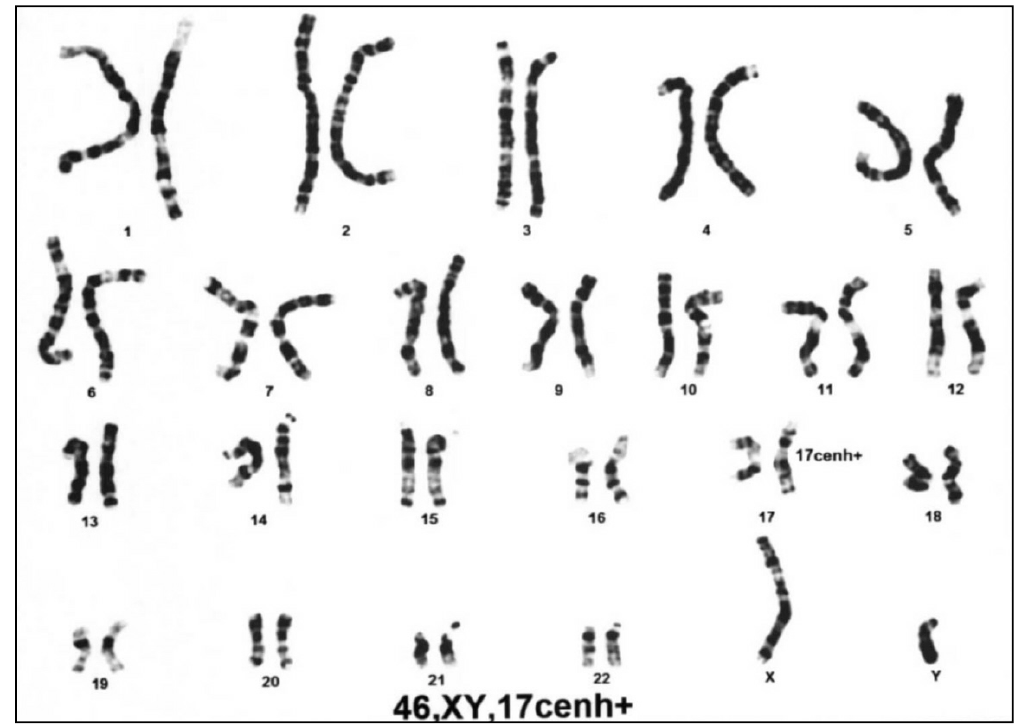
Figure 2. The cytogenetic chromosomal study showed no abnormal finding in the 46 XY chromosomes, excluding the normal variation in 17 centromeric heterochromatin.